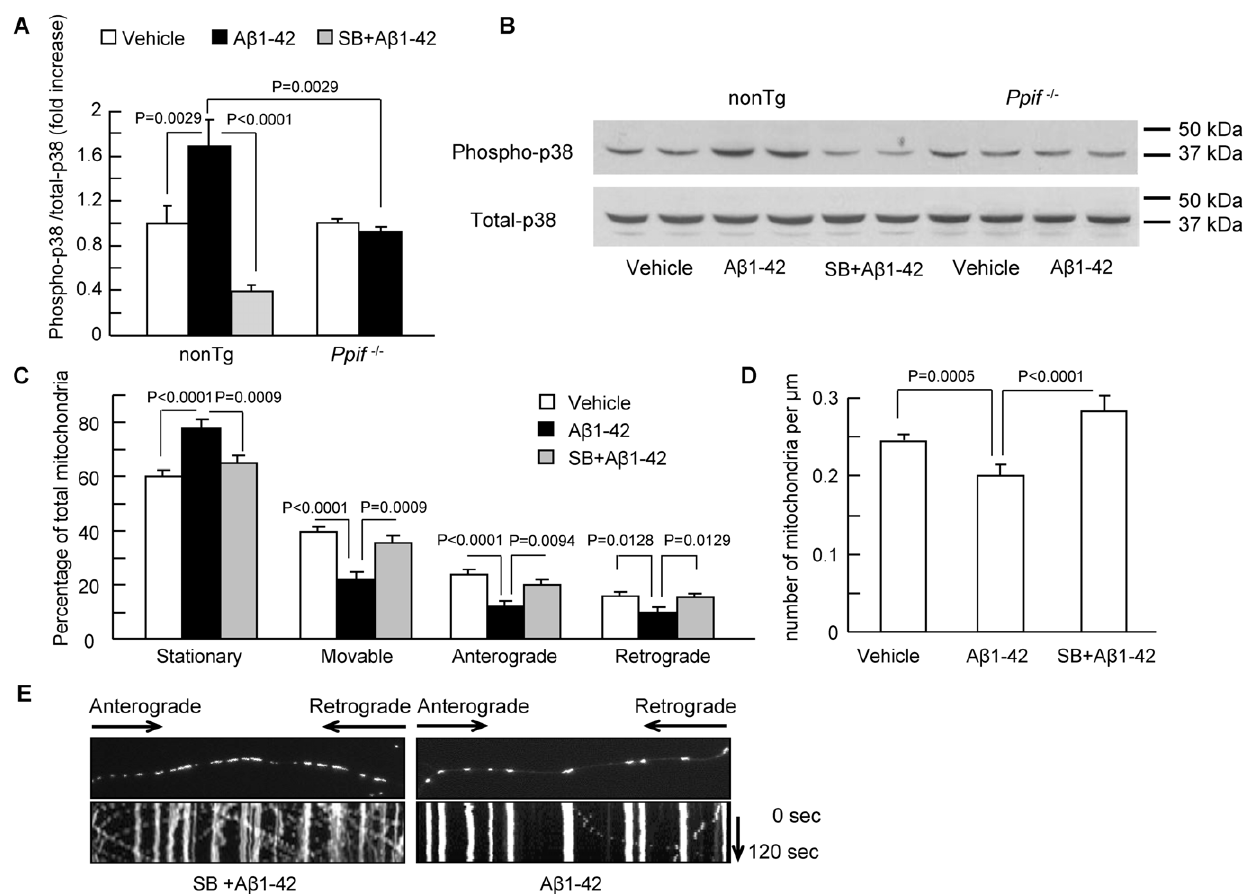
Figure 5. Effect of CypD on A b -induced activation of p38 MAP kinase and axonal mitochondrial motility. ( A ) Quantification of phospho- p38 immunoreactive bands (pT180/pY182) in hippocampal neurons treated with vehicle, A b , or SB203580 (SB, 1 m M) plus A b , respectively, which was normalized for the total p38. ( B ) Representative immunoblots for phospho- and total-p38. ( C–E ) Administration of p38 inhibitor, SB203580 (1 m M, 24 hours) to cells ameliorated A b -induced axonal mitochondrial motility changes ( C ) and mitochondrial density ( D ). ( E ) Kymographs showed the protected effects of axonal mitochondrial movement after SB203580 treatment. Scale bar is 10 m m.